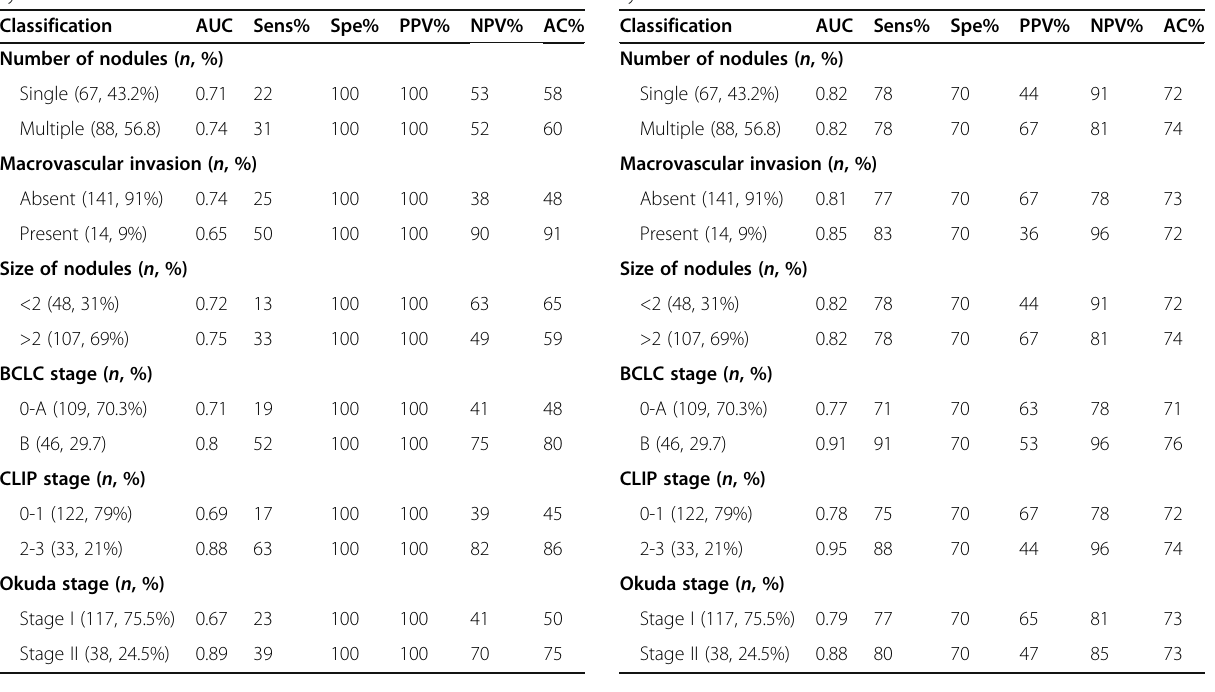
Table 3 Diagnostic power of AFP to discriminate patients with HCC from patients with cirrhosis in different three staging